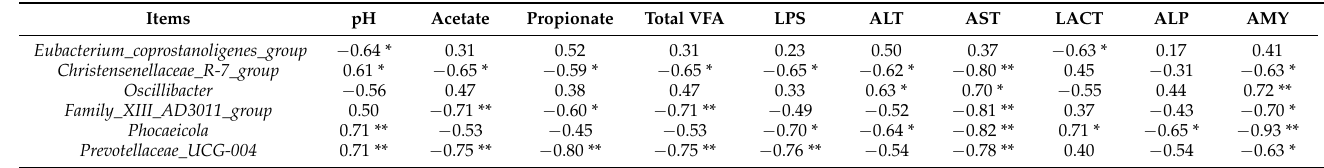
Table 2. Spearman’s correlation analysis between colonic bacterial community and metabolites in growing goats a